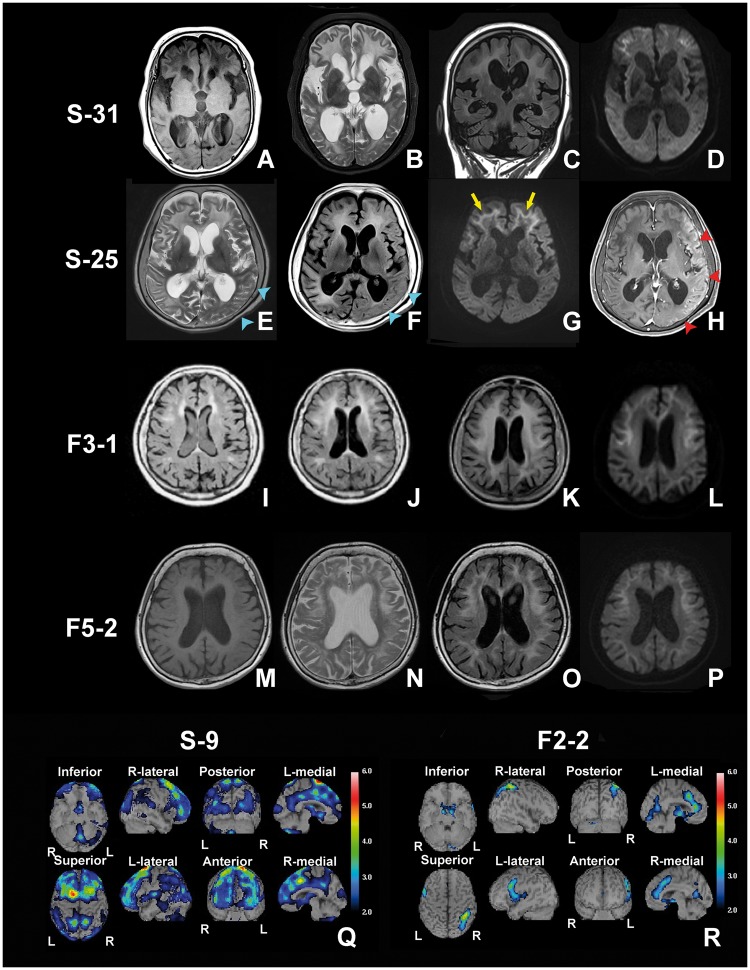
The results of NIID head MRI and SPECT. Head MRI findings of Subject S-31 (sporadic NIID) (A–D), Subject S-25 (sporadic NIID) (E–H), Subject F3-1 (familial NIID) (I–L) and Subject F5-2 (familial NIID) (M–P). (A and M) T1-weighted image. (B, E and N) T2-weighted image. (C, F, I–K and O) FLAIR image. (D, G, L and P) DWI image. (H) Gadolinium-enhanced T1-weighted image. (A–D) Head MRI findings of Subject S-31 at age 72 years, almost akinetic mutism state. Prominent leukoencephalopathy, DWI high intensity signal in corticomedurally junction and ventricular distention were observed (D). (E–H) Head MRI findings at the presence of encephalitic symptom of Subject S-25. On T2 (E) and FLAIR (F) image, brain oedema is observed (blue arrowhead). On DWI, oedematous portion showed slightly high intensity but weaker than corticomedurally junction high intensity signal (yellow arrow) (G). Oedematous portion showed high intensity on gadolinium enhanced T1 image (red arrow head) (H). (I–L) Progress of leukoencephalopathy in familial NIID Subject F3-1 at age 53 (I), age 58 (J) and age 64 (K and L). High intensity area of FLAIR image extended remarkably. (M–P) Head MRI findings of familial NIID Subject F5-2 presented dementia dominantly. Findings are almost identical to sporadic case. (Q and R) The results of easy Z-score imaging system (eZIS) analysed data of 99mTc-ECD SPECT. Subject S-9 showed severe regional cerebral blood flow decline and Subject F2-2 eZIS data showed light regional cerebral blood flow decline.